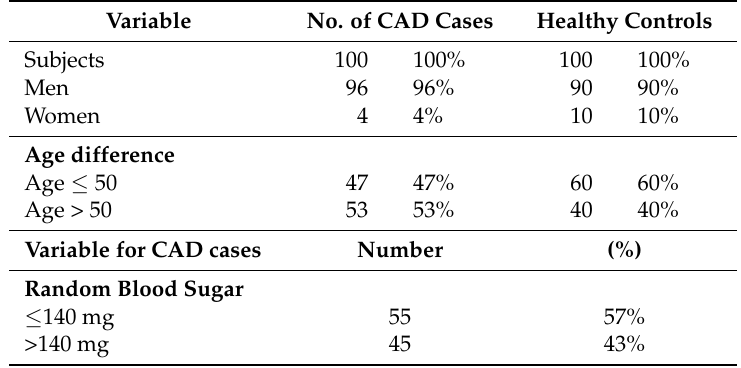
Table 3. Clinicopathological characteristics of coronary artery disease (CAD) patients and